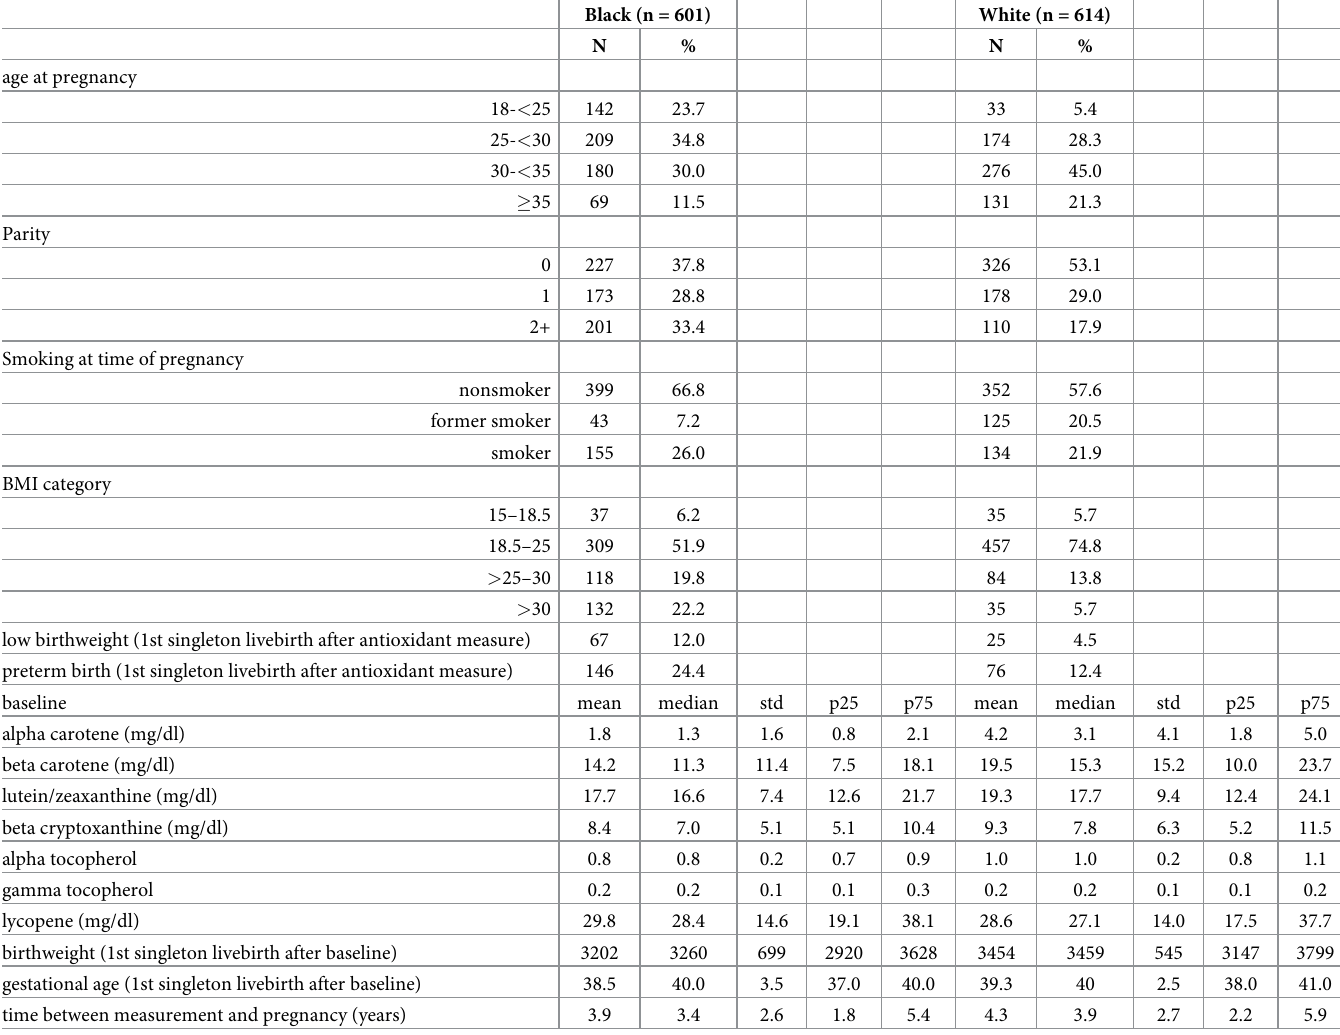
Table 1. Description of study population at their CARDIA index exam in 1985–86 or 1992–93, women with antioxidant measures and subsequent singleton live- birth (n =